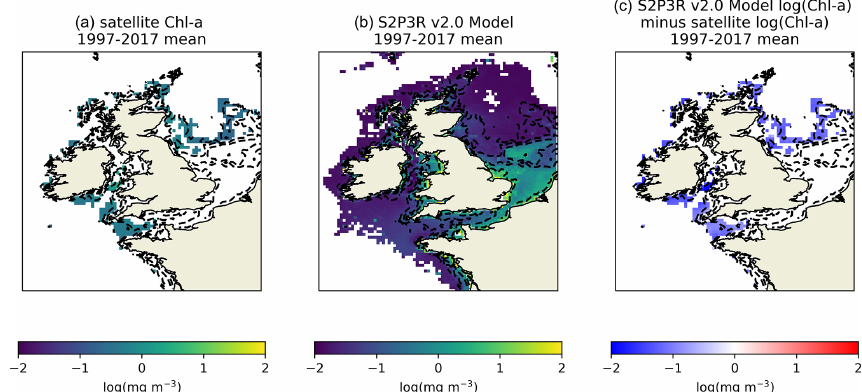
Figure 13. Comparison of Northwest European Shelf surface level chlorophyll- a concentrations with satellite based chlorophyll- a estimates (Sathyendranath et al., 2020). Figures present an annual mean of all data available between 1997 and 2017 inclusive. Dashed lines represent